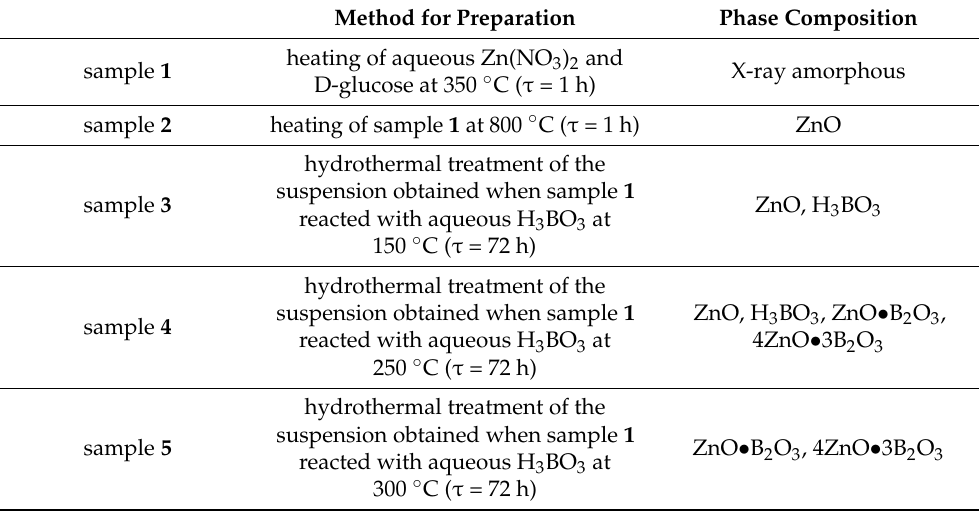
X-ray amorphous ZnO, H 3 BO 3